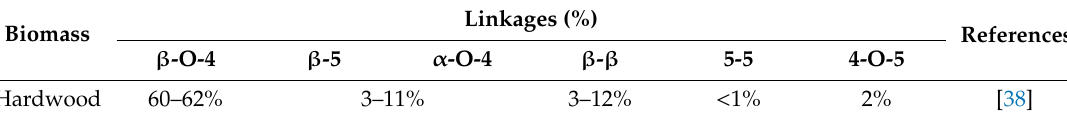
Table 1. Frequency of lignin linkages in native hardwood species.